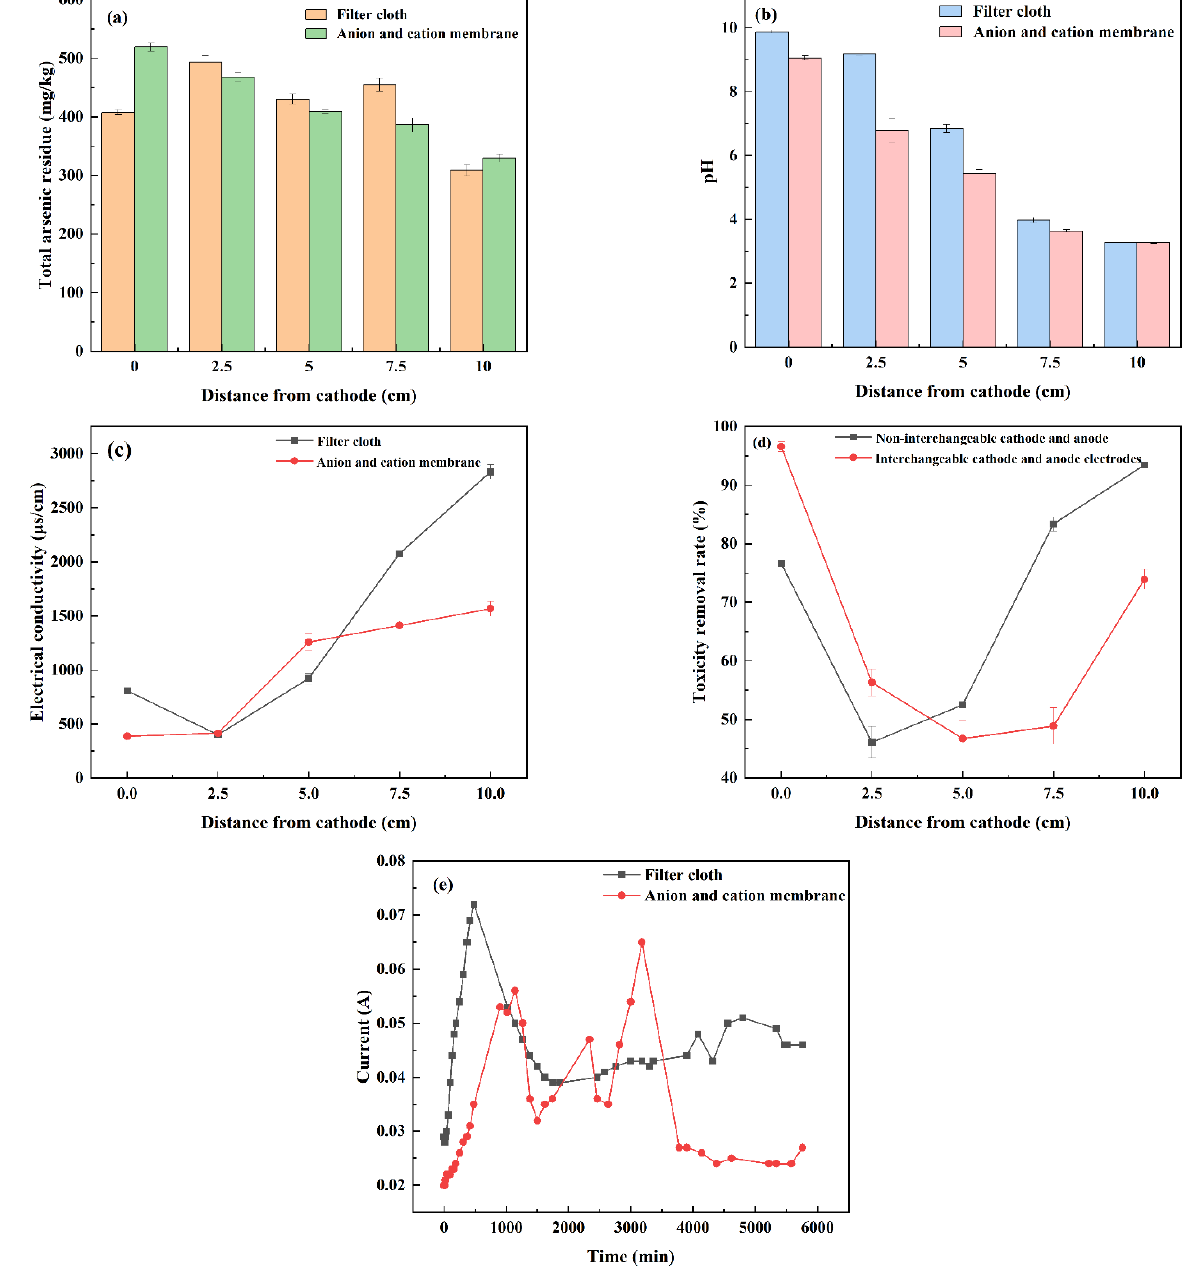
Figure 7. Effect of anion and cation membranes on polarization phenomenon for the remediation of arsenic-contaminated soil by EK-PRB. Total arsenic residue ( a ), pH ( b ), electrical conductivity ( c ), toxicity removal rate ( d ) and current ( e ).